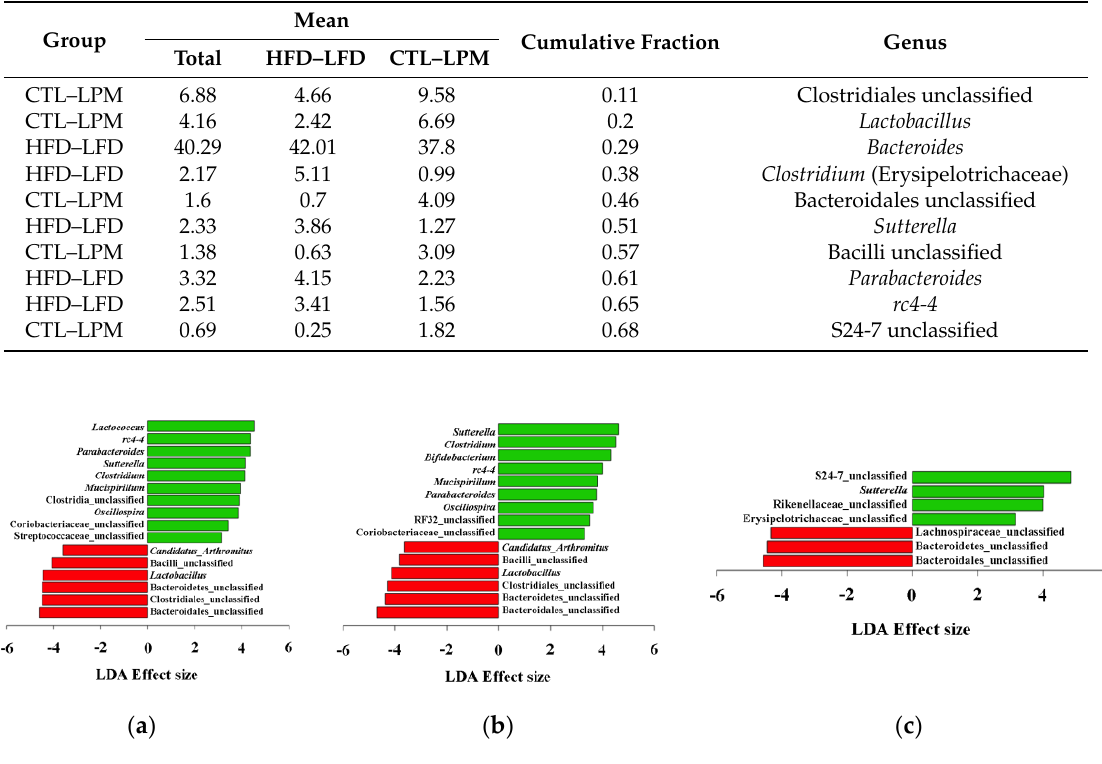
Figure 3. Analysis of differentially abundant genera. Red bars indicate control samples and green bars indicate high-fat diets ( a ), low-fiber diets ( b ), and loperamide administration ( c ).